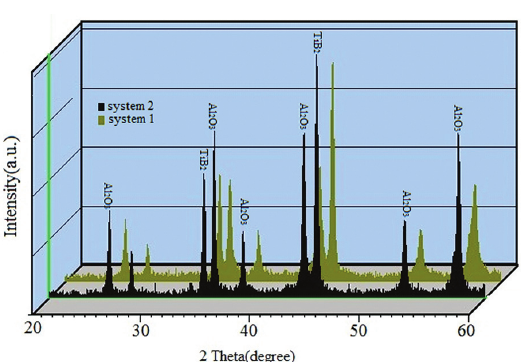
Figure 13. comparison of the heat released resulted from MSR mode in both